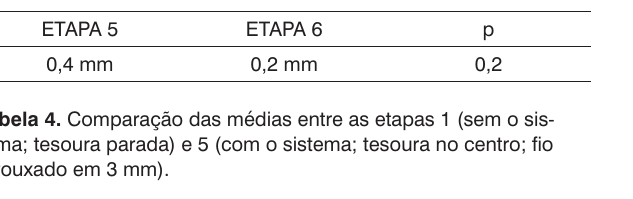
Tabela 3. Comparação das médias entre as etapas 5 (com o siste- ma; tesoura no centro; fio afrouxado em 3 mm) e 6 (com o sistema; tesoura na lateral direita; fio afrouxado em 3 mm).